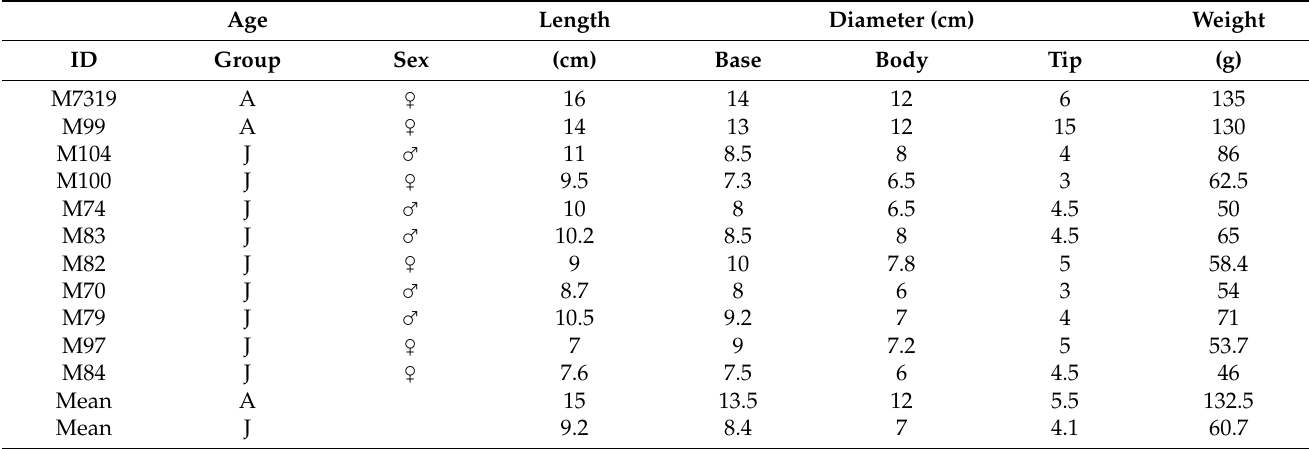
Figure 2. Dorsal surface of the South American fur seal tongue isolated from the oral cavity: ( 1 ) base; ( 2 ) body; ( 3 ) vertex (blunt and slightly bifid); ( 4 ) black coloration; ( 5 ) tongue ridge. Table 1. Morphometric data of the tongue of Arctocephalus australis . A: adult; J: juvenile.